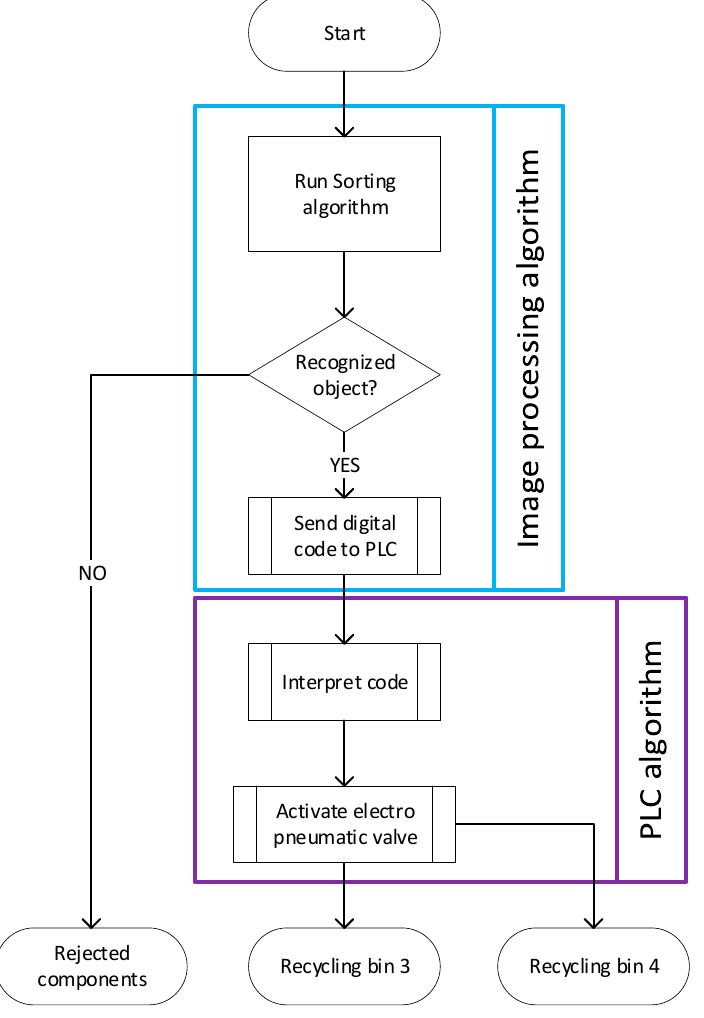
Figure 11. Flow chart diagram of the second experimental sorting stage.